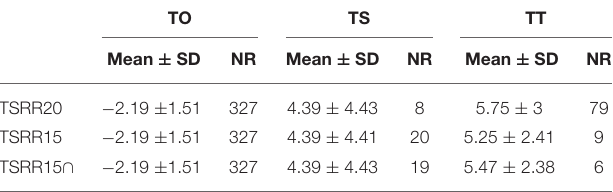
TABLE 4 | Heart rate turbulence parameters calculated with different #TSRR. TO TS TT